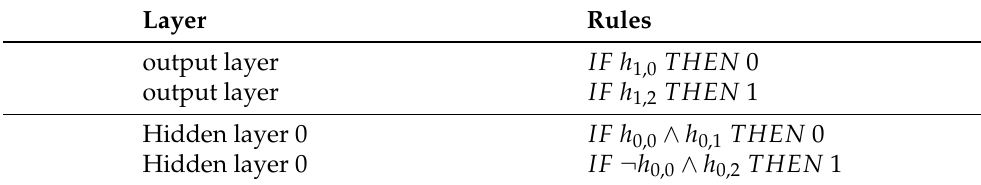
Table A13. DEXiRE Intermediate rule sets for the Prima Indians dataset.